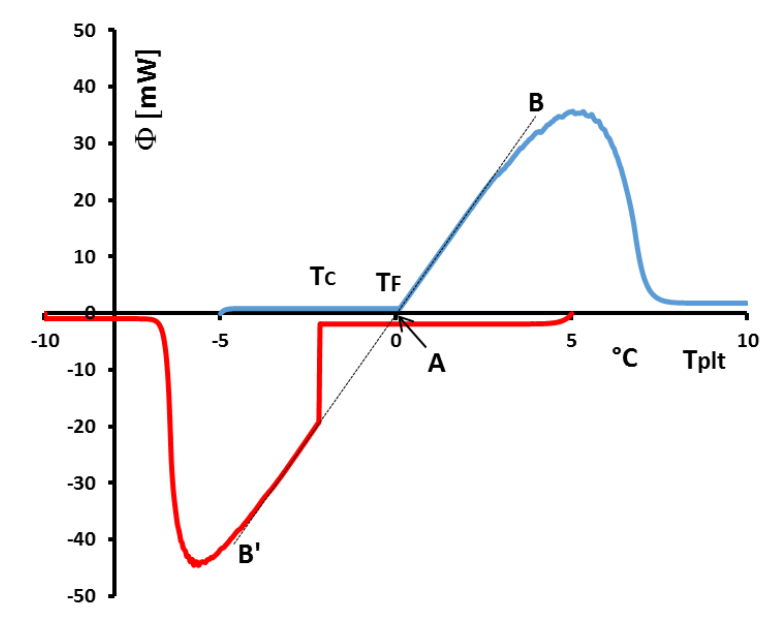
2 K/min (red curve) with a supercooling of −